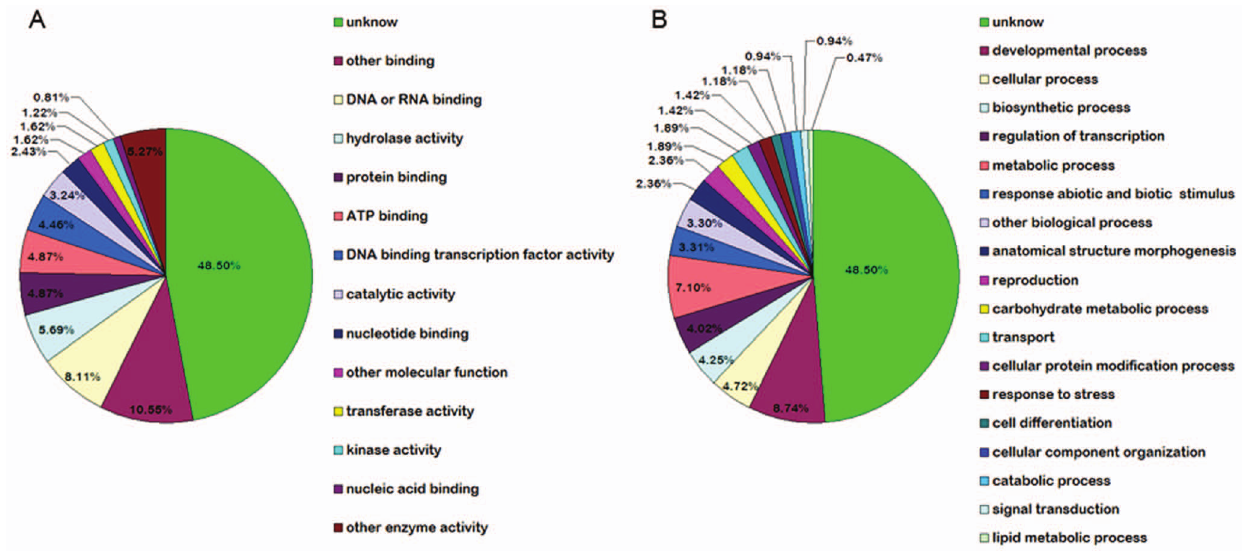
Figure 4. Putative molecular functions (A) and biological processes (B) of known and new candidate miRNA targets. The GO analysis was carried out according to A. thaliana and O. sativa databases.